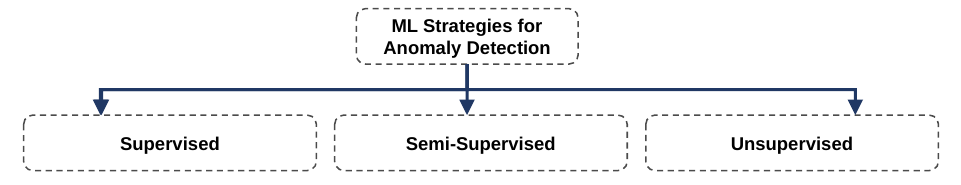
Figure 4. Taxonomy of ML strategies for AD [13,15].